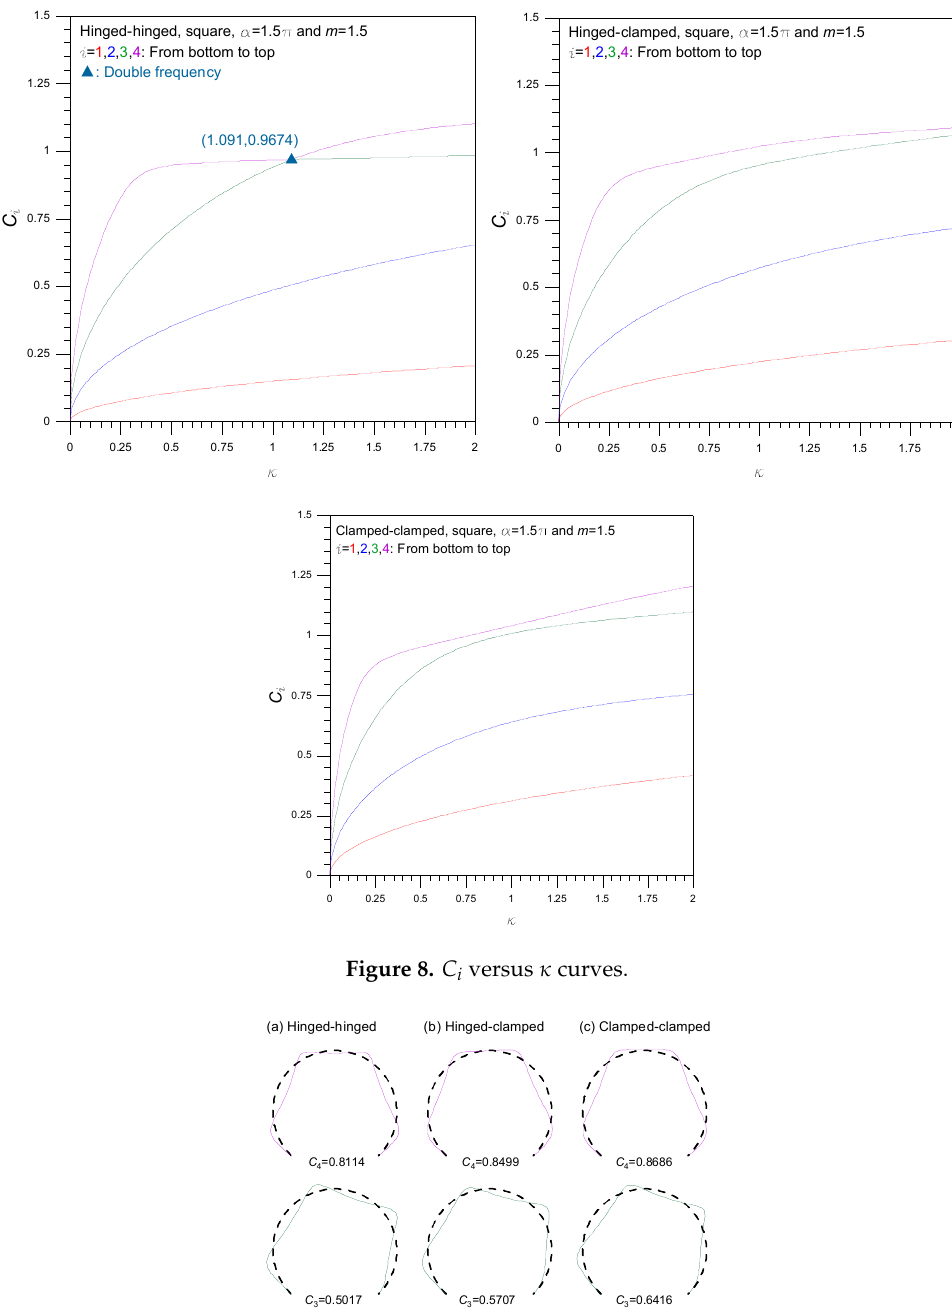
Figure 9. Example of mode shapes.